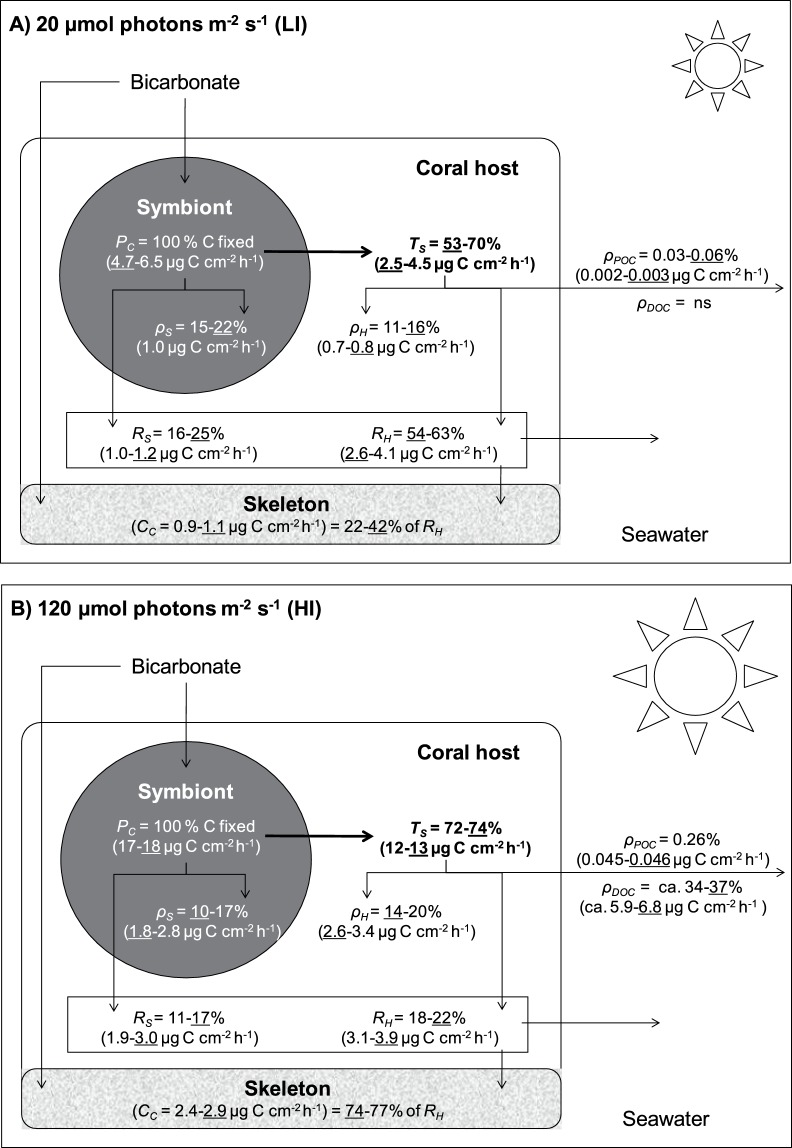
Mass-balanced results of photosynthate translocation and carbon budget in C. caespitosa.Results under (A) low (LI) and (B) high irradiances (HI), based on 13C experiments after 48 h of incubation (or 24 h for POC). Underlined values are for fed colonies. Symbols are defined in the text and summarised in Table 2. Data represent means and standard errors of means of n = 3 measurements for 13C-based rates (ρS, ρH, ρPOC, ρDOC, and TS) and n = 6 measurements for rates of photosynthesis (PC), respiration (RS, and RH) and calcification (CC).